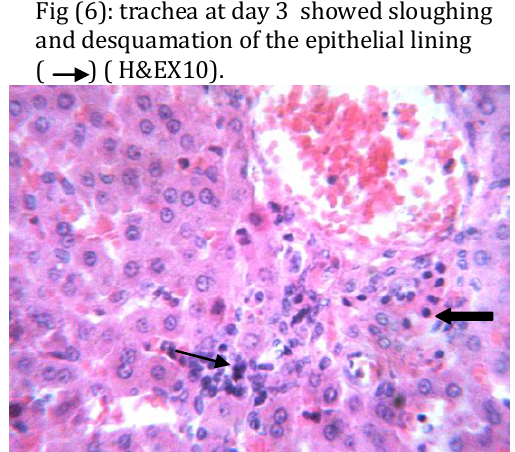
Fig (8) liver at day 3 pi. showed inflammatory cells infiltrated between hepatocytes and also around the central vein consist mainly from lymphocytes ( ) and macrophage ( ) (